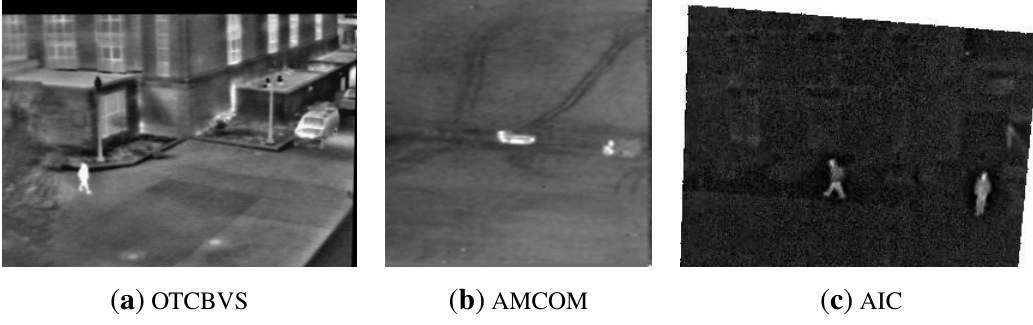
Figure 2. Excerpts from the considered dataset. ( a ) OTCBVS (Object Tracking and Classification Beyond the Visible Spectrum) sequence; ( b ) Army Missile Command (AMCOM) sequence; ( c ) AIC (Adaptive Information Cluster) Thermal Database